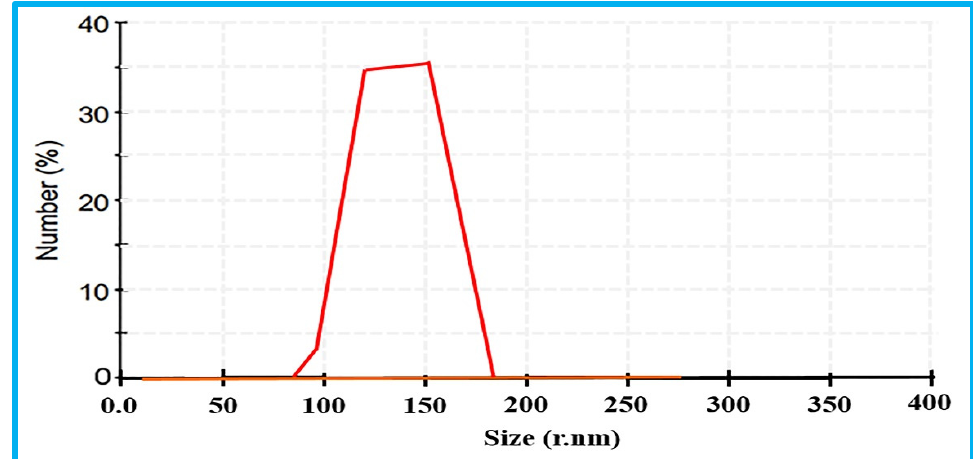
Figure 1. Average hydrodynamic size of NPZRO.